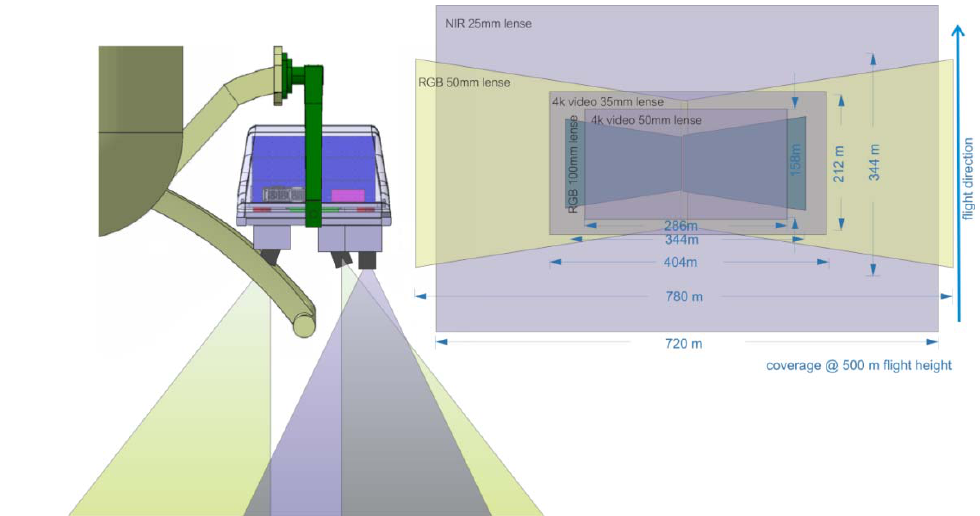
Figure 4: Viewing configuration and footprints of the 4k system with different configurations Canon EOS 1D-X (left/right) Canon EOS 1D-C (nadir)